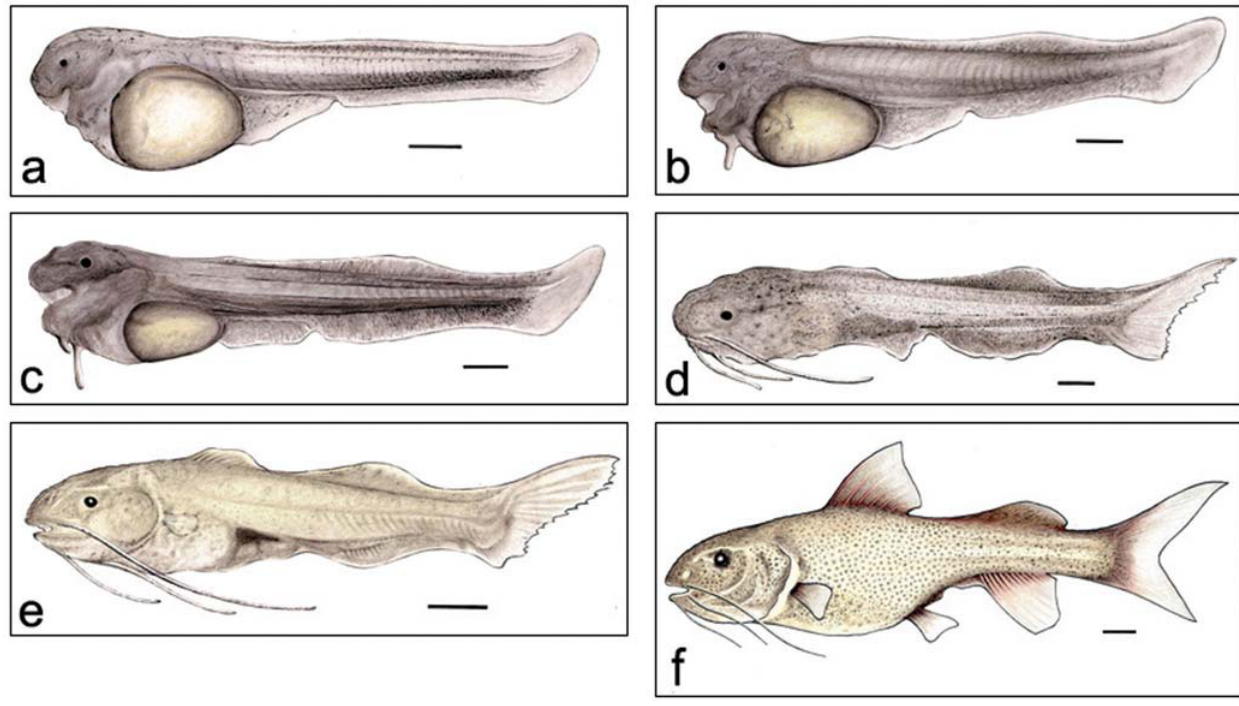
Fig. 2. Drawings of free embryos ( a - c ), larvae ( d - e ) and juvenile ( f ) of hatchery - raised jahus. a ) free embryo (18 h post hachting, HPH; 5.3 mm TL) presenting pigmented retina, opened mouth and slightly pigmented primordial fin fold; bar = 0.5 mm. b ) free embryo (24 HPH, 5.9 mm TL) showing developing mental barbel and pigmented primordial fin fold except in the caudal portion; bar= 0.5 mm. c ) free embryo (36 HPH, 6.4 mm TL) showing growing mental barbels, primordial fin fold chromatophores vertically arranged, yolk sac well reduced in size, outline of adipose fin was present, dorsoflexion of notochord was completed; bar = 0.5 mm. d ) larva (128 HPH, 8.6 mm TL) showing developing maxillary and mental barbels, outline of pelvic, and anal fins; bar = 0.5 mm. e ) larva (152 HPH, 14.4 mm TL) in which pectoral, dorsal and caudal fins are seen; bar = 1.0 mm. f ) juvenile jahu (224 HPH, 16.6 mm TL); bar = 1.0